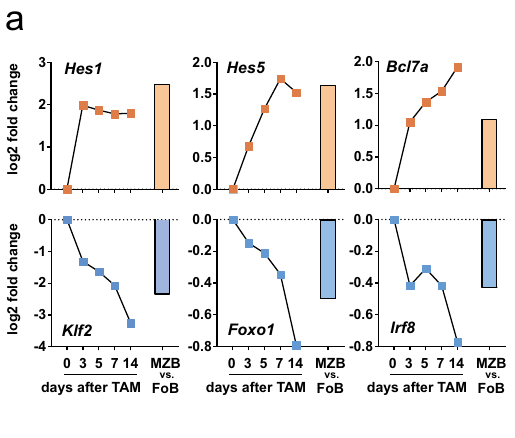
Fig. 5 Notch2IC regulates genes involved in transcription and homing. a Mean fold changes in RNA levels of transcription factors and transcriptional regulators in hCD2 + versus hCD2 − cells over all time points after TAM treatment. Fold changes of wild type MZB versus FoB samples are shown as bar graph. b Enrichment plots of GSEA analysis using Klf2 -KO gene sets de fi ned by a microarray analysis of Klf2 -de fi cient FoB cells published by Hart and colleagues 39 . The GSEA shows a signi fi cant enrichment of KLF2 target genes at the top and bottom ends in the ranked dataset of hCD2 + (day 14 after TAM) versus hCD2 − cells. c Mean fold changes in RNA levels of genes involved in B cell migration and MZ homing. Analysis according to ( a ). Colored gene names are KLF2 target genes from ( b ) which are up- (orange) or down- (blue) regulated in the conditional Klf2 knockout.